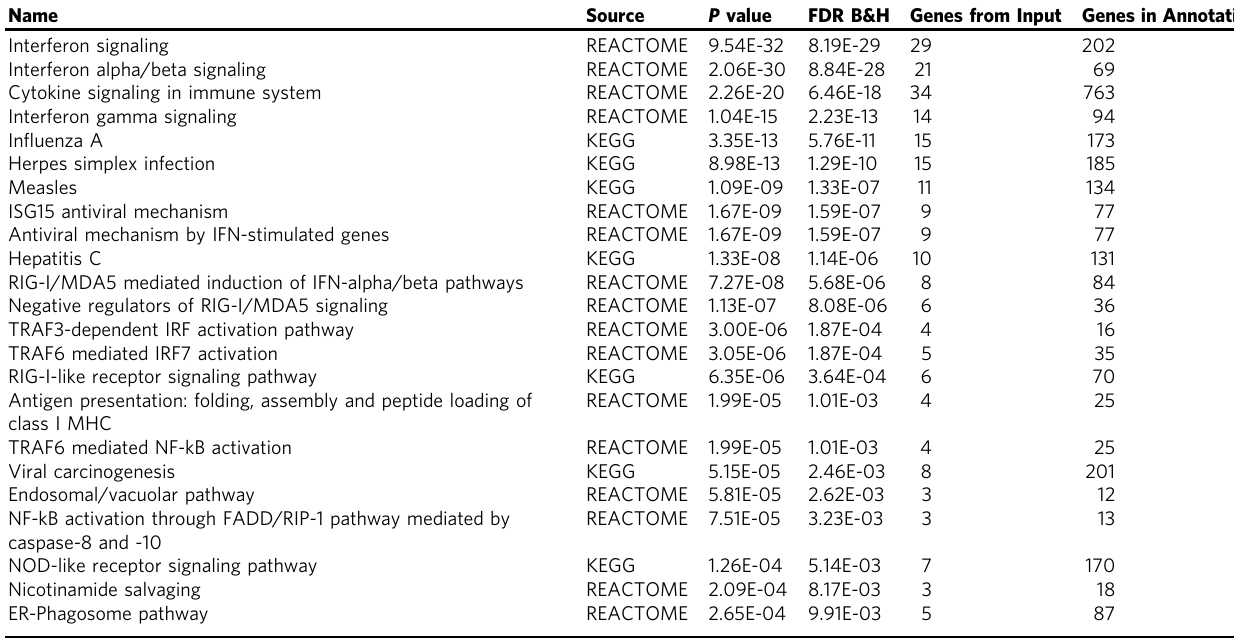
Table 2 Signi fi cantly enriched pathways in cluster-associated CpGs